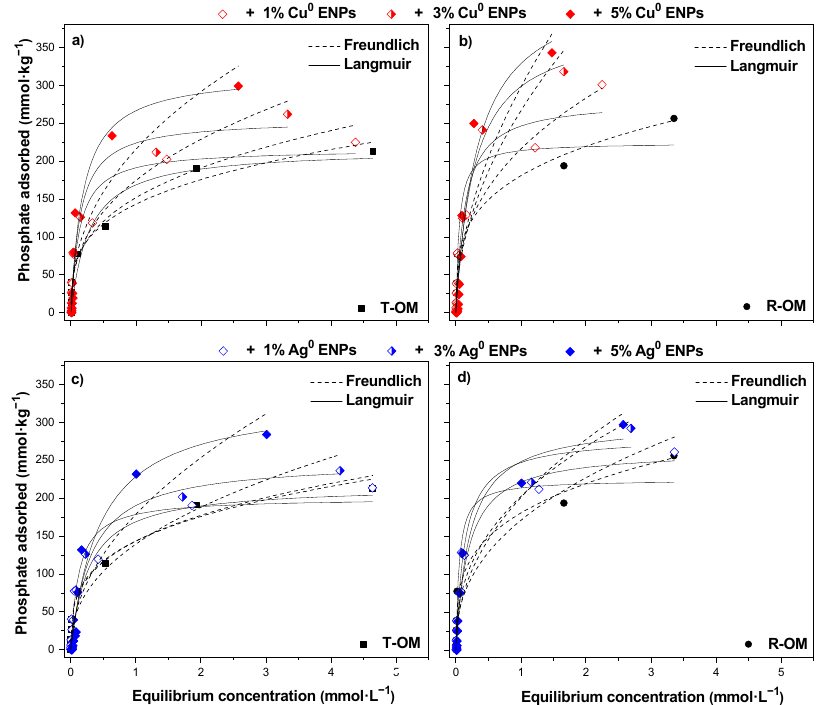
Figure 4. Phosphate adsorption isotherms at pH 5.5 ± 0.2 of the solutions in the presence of Cu 0 ENPs on soil with ( a ) total organic matter (T-OM) and ( b ) partial removal of organic matter (R-OM) and Ag 0 ENPs on soil with ( c ) T-OM and ( d ) R-OM modelled by the Langmuir and Freundlich models. Table 2. The isotherm models used for the description of phosphate adsorption. Isotherm Equations